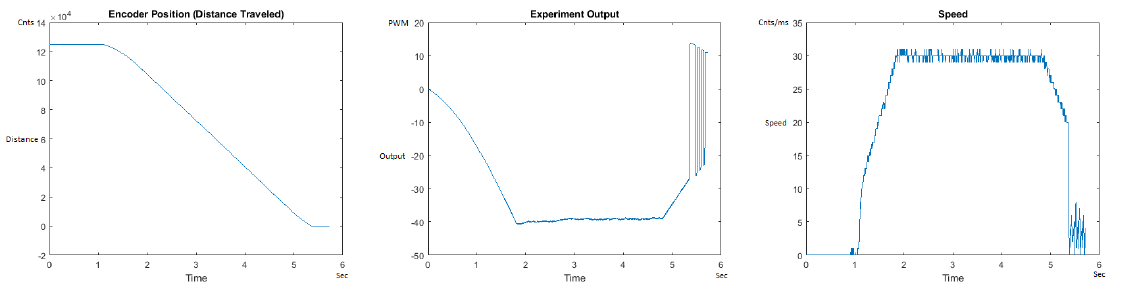
Figure 23. Encoder position, output and speed plots for PID++ DOWN operation— Vmax 30 cnts/ms, Adesired 0.015 cnts/ms 2 —10 g.